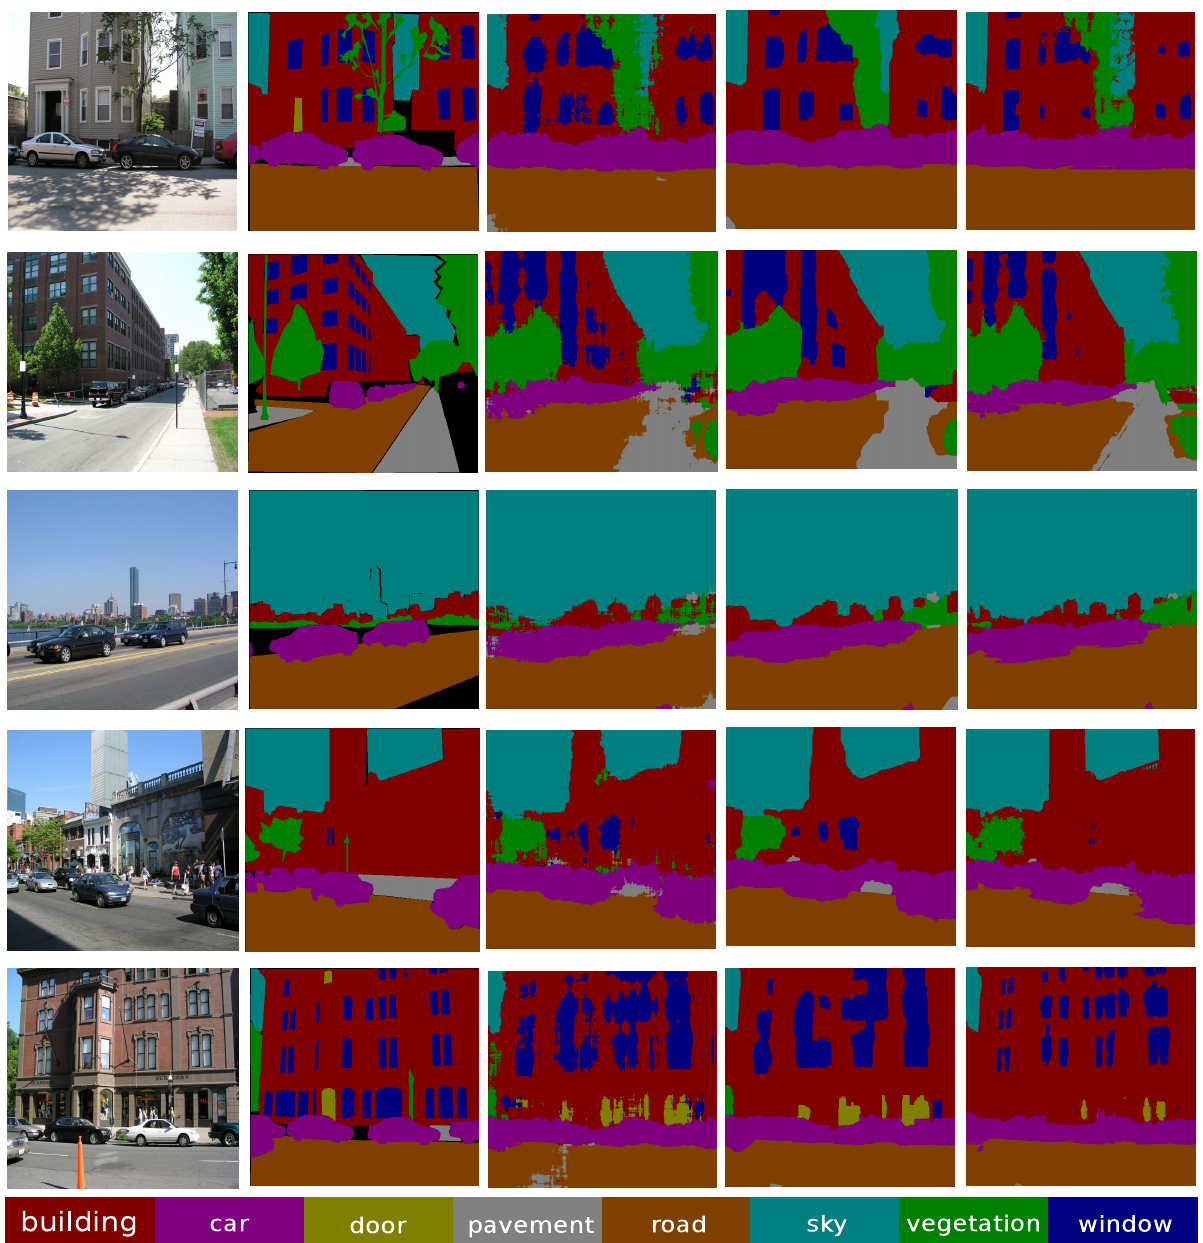
Figure 5. The qualitative results of the LabelMeFacade dataset. First column are examples of the testing images and 2nd-column are the corresponding ground truth. (3rd-column to 5th-column) man-made scene semantic segmentation results using the Textonboost classifier, the CRF model and the fully connected CRF model, respectively. The last row is the legend. The fully connected CRF model obtains more accurate and detailed results than the low connected